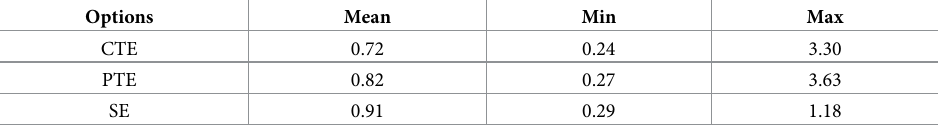
Table 2. Overall description of the annual average efficiency of the Super-EBM ( n =